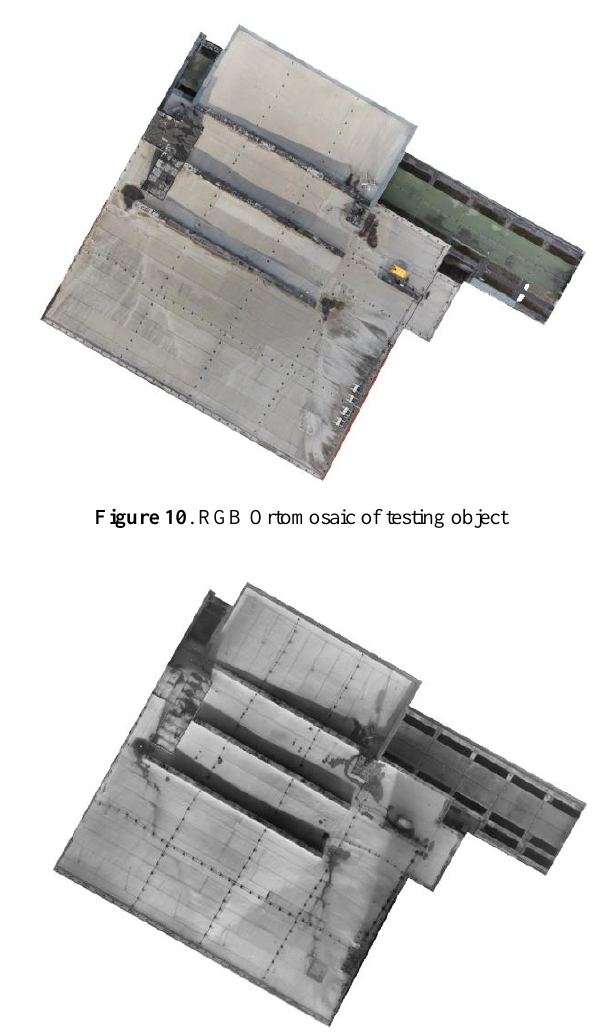
Figure 11 . TIR Ortomosaic of testing